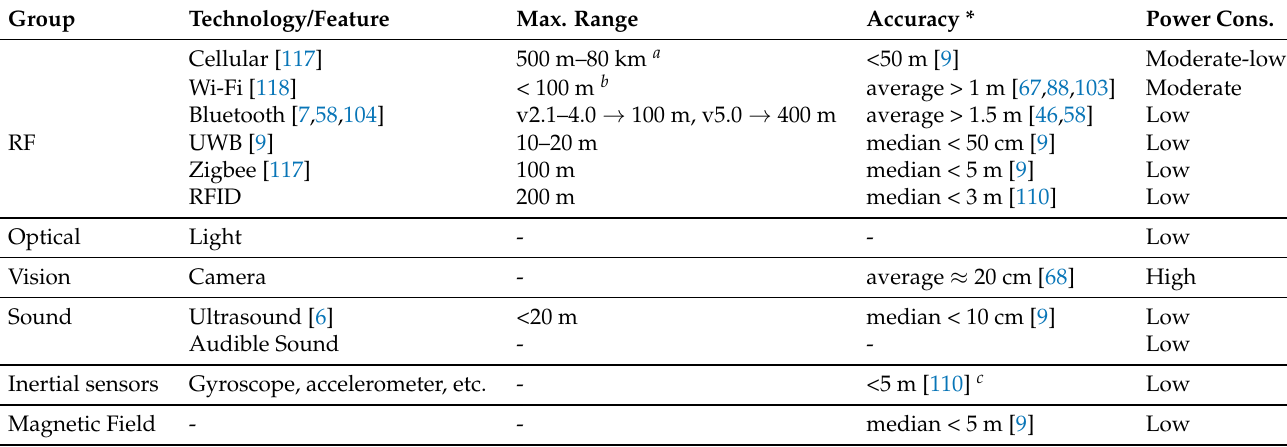
Table 3. Features of the Indoor Positioning